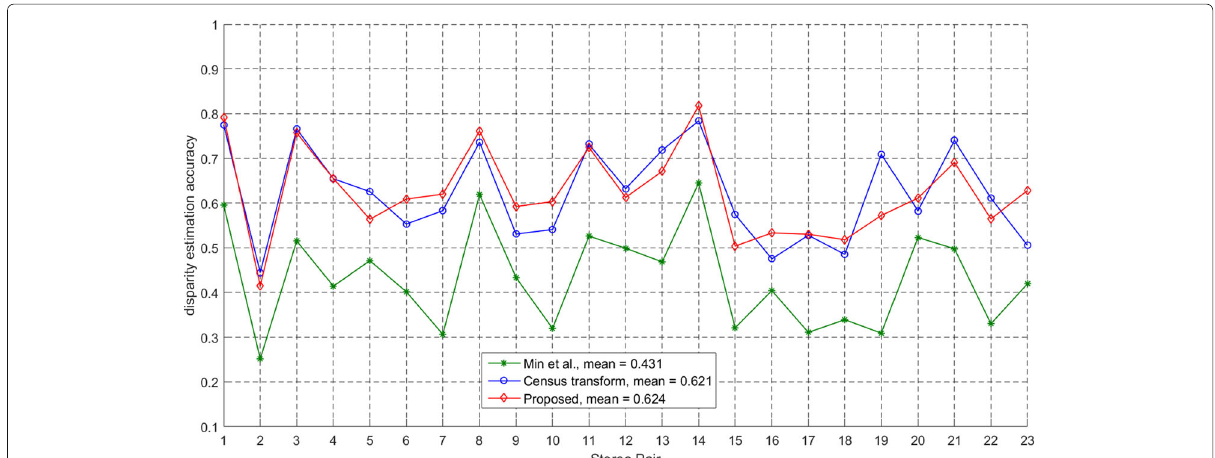
Fig. 10 Performance comparison of three methods on the 2014 Middlebury Stereo